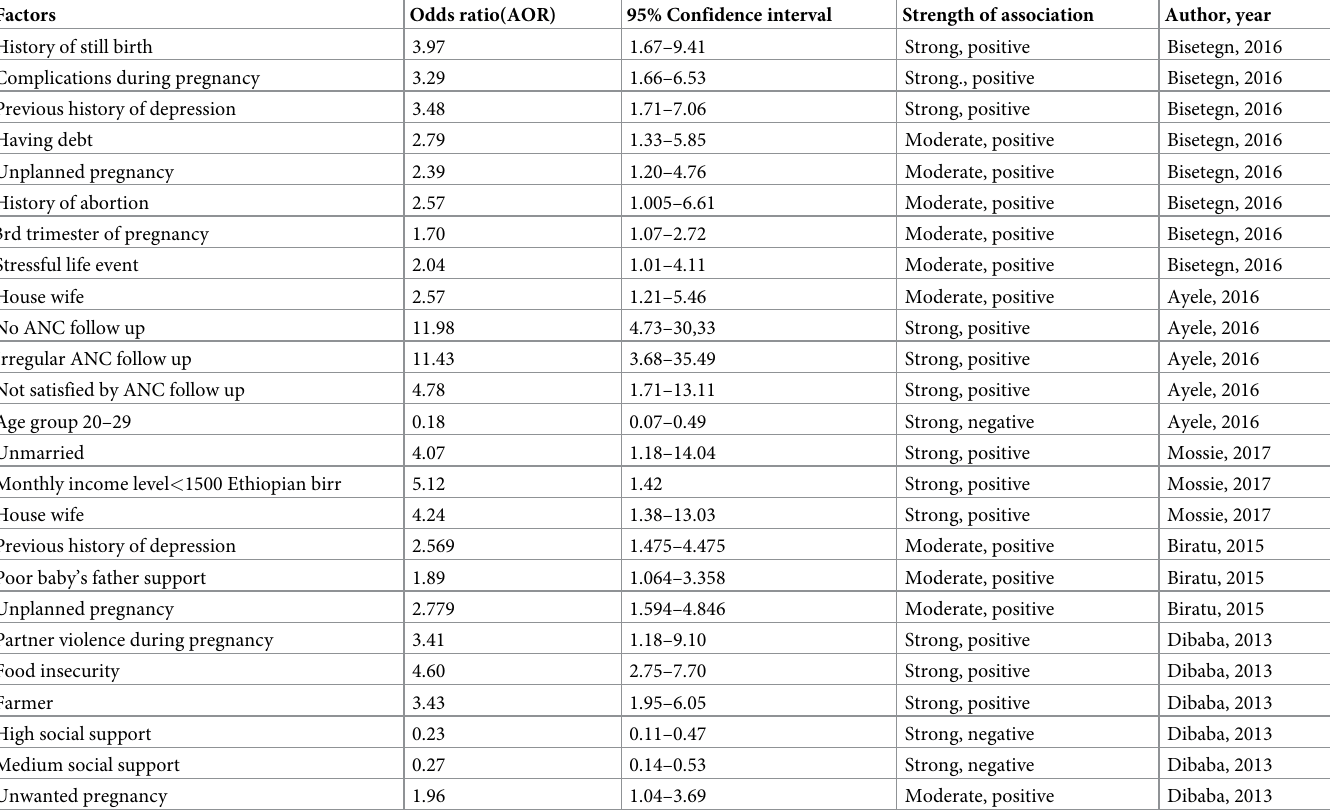
Table 4. Characteristics of factors associated with antenatal depression in Ethiopia by their odds ratio, confidence interval strength of association, author and year.